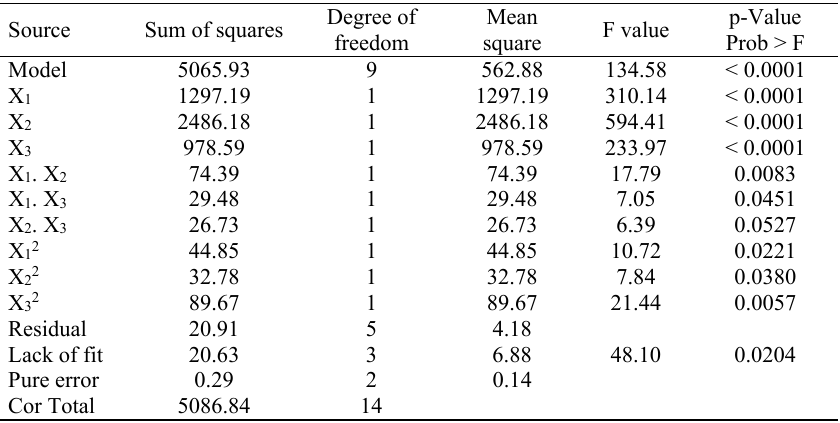
Table 4. Analysis of variance (ANOVA) for the response surface quadratic model. Table 4: Analysis of variance (ANOVA) for the response surface quadratic